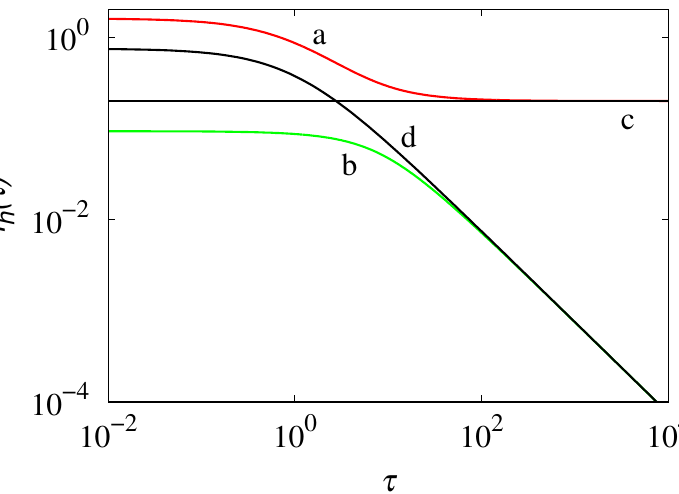
Figure 9. f h ( τ ) vs. τ —line (a) refers to the fastest and line (b) to the slowest mode—for the model described in the main text. Lines (c) and (d) represent the asymptotic scalings described by Equations (49) and (50),